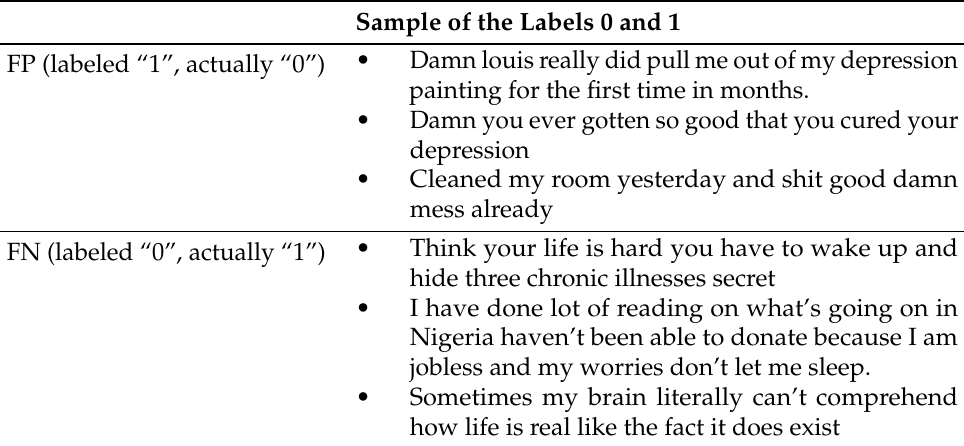
Table 2. Elaboration of TPs, TNs, FPs, and FNs with samples.